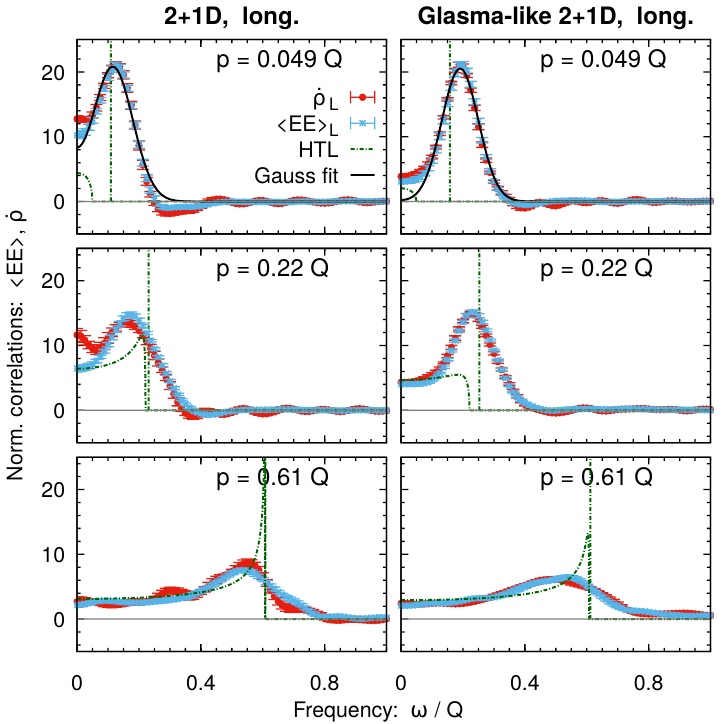
Figure 4 . The longitudinal normalized statistical correlator h EE i L ( t, ω, p ) / h EE i L ( t, ∆ t =0 , p ) and normalized dotted spectral function ˙ ρ ( t, ω, p ) / ˙ ρ ( t, ∆ t =0 , p ) for both 2+1D theories for the same L L momenta and with analogous HTL and fitting curves as in figure 3. For p = 0 . 61 Q we used the smaller time window ∆ t = 60 /Q to reduce ringing of the dotted spectral max